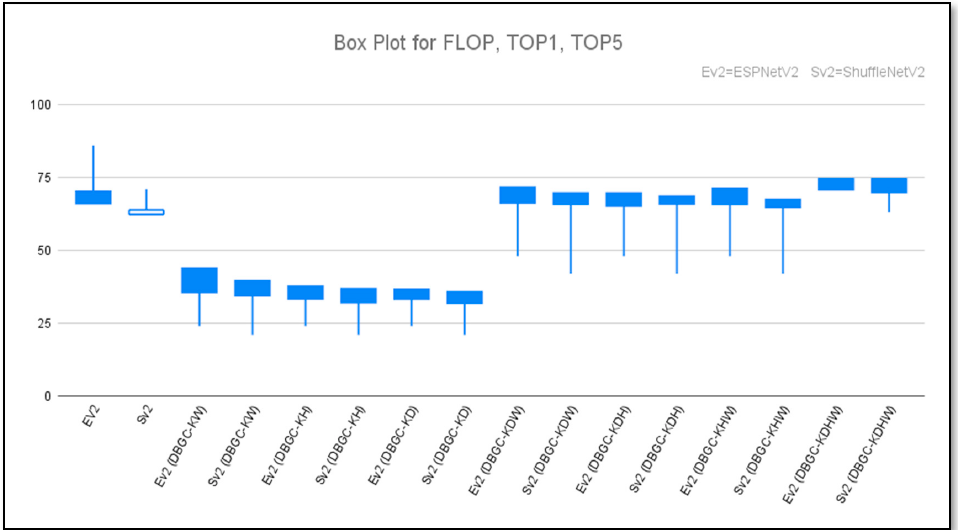
Figure 26. Box plot to show unoptimized, semi-optimized, and optimized kernel performances for ESPNetv2 versus ESPNetV2 (DBGC) and ShuffleNetv2 versus ShuffleNetV2 (DBGC).